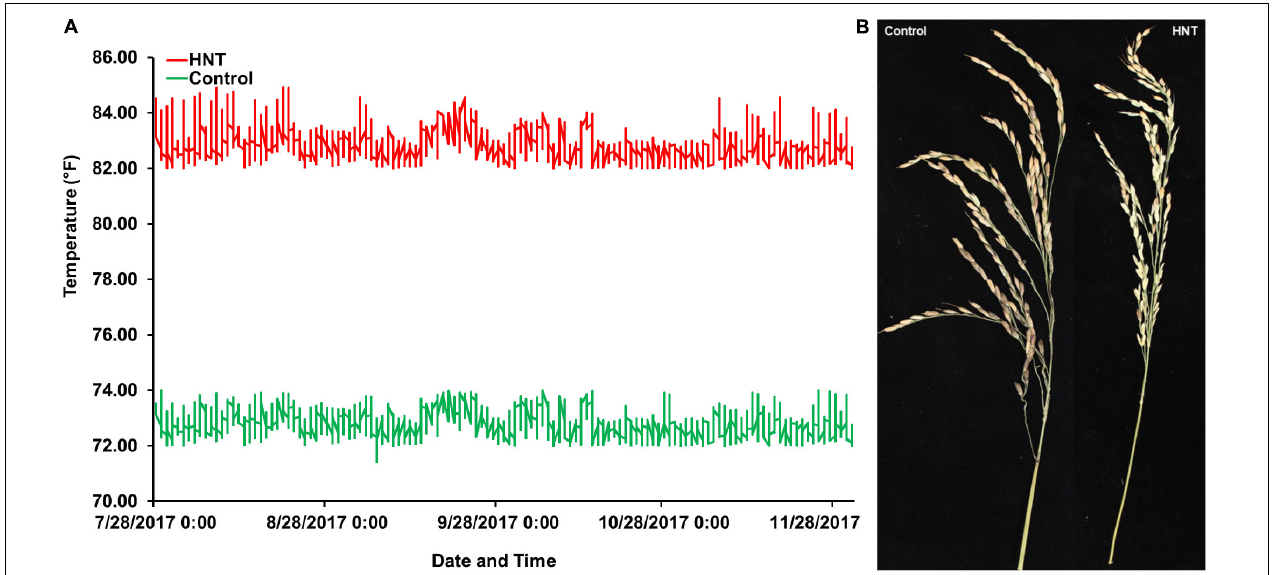
FIGURE 1 | Experiment comparing high nighttime temperature (HNT) stress and control treatments on the panel of 190 diverse rice accessions of the USDA rice mini-core collection (URMC). (A) The nighttime temperatures record during the screen of the URMC panel. The nighttime temperature during each night was plotted across the duration of the experiment for the HNT stress and control treatments, the red line plots the HNT stress temperature treatment, and the green line is the plot of the control treatment at nighttime. The HNT stress temperature was stably maintained at 82.4 ± 1 ◦ F (28 ± 1 ◦ C), while the control treatment was held steady at 72 ± 1 ◦ F (22.2 ± 1 ◦ C) during the experiment until harvest maturity. (B) The effects of HNT stress compared to the control treatment on panicle length (PL) in cm and number of spikelets per panicle (NSP) in the panel.